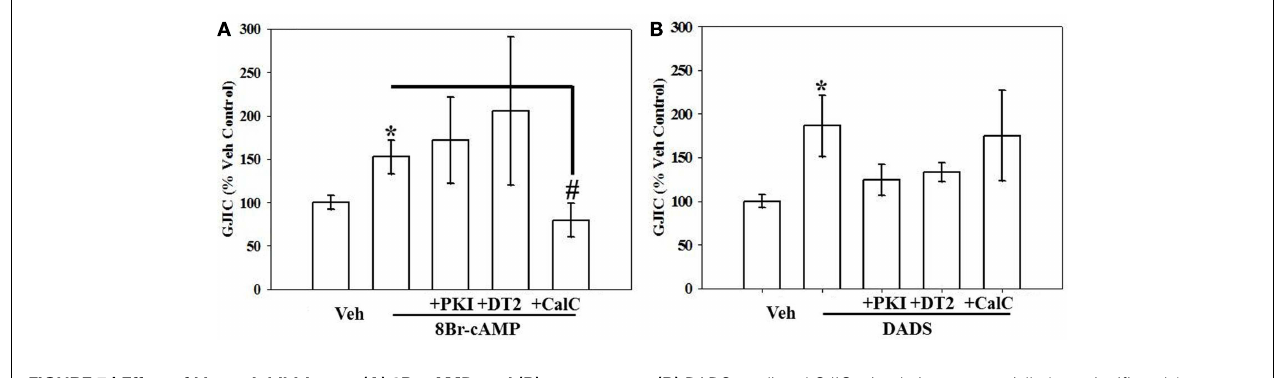
(B) DADS-mediated GJIC stimulation was partially (non-significantly) reversed by PKA or PKG inhibition. Data are mean ± SE from an n = 4 for the inhibitors treatment and an n = 6–9 for control, 8Br-cAMP and DADS. Student–Newman–Keuls method for multiple comparisons following one-way ANOVA was used. * p < 0.05 compared with normalized vehicle controls, # p < 0.05 compared with cAMP-treated cells.